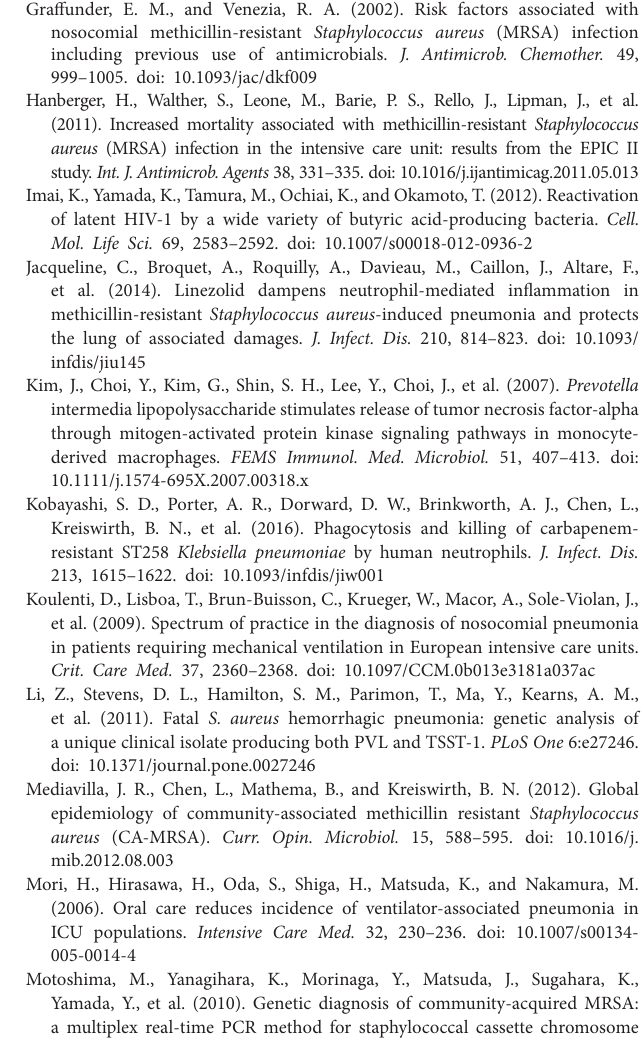
Supplementary Figure 1 | Time-dependent changes in (A) rnaIII, (B) hla, and (C) spa mRNA expression of HUYM MRSA in vitro. Bars represent the mean relative mRNA expression. Data are representative of three replicates from three independent experiments. * p < 0.05; ** p < 0.005. Supplementary Figure 2 | Time-dependent changes in (A) rnaIII, (B) tst, (C) hla, and (D) spa mRNA expression of the NU1643 TSST-producing MRSA strain in vitro. Bars represent the mean relative mRNA expression. Data are representative of six replicates. Similar results were obtained from two independent experiments. * p < 0.05; ** p < 0.005. Supplementary Figure 3 | Time-dependent changes in (A) rnaIII, (B) pvl, (C) hla, and (D) spa mRNA expression of the NU1516 PVL-producing MRSA strain in vitro. Bars represent the mean relative mRNA expression. Data are representative of six replicates. Similar results were obtained from two independent experiments. ** p <